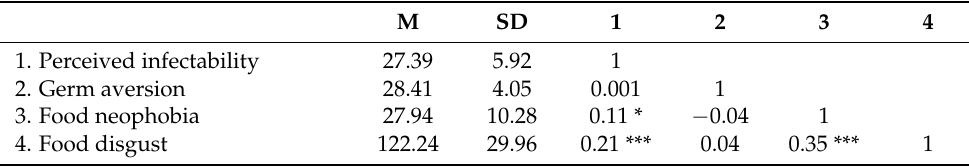
Table 1. Descriptive statistics and correlations between the studied